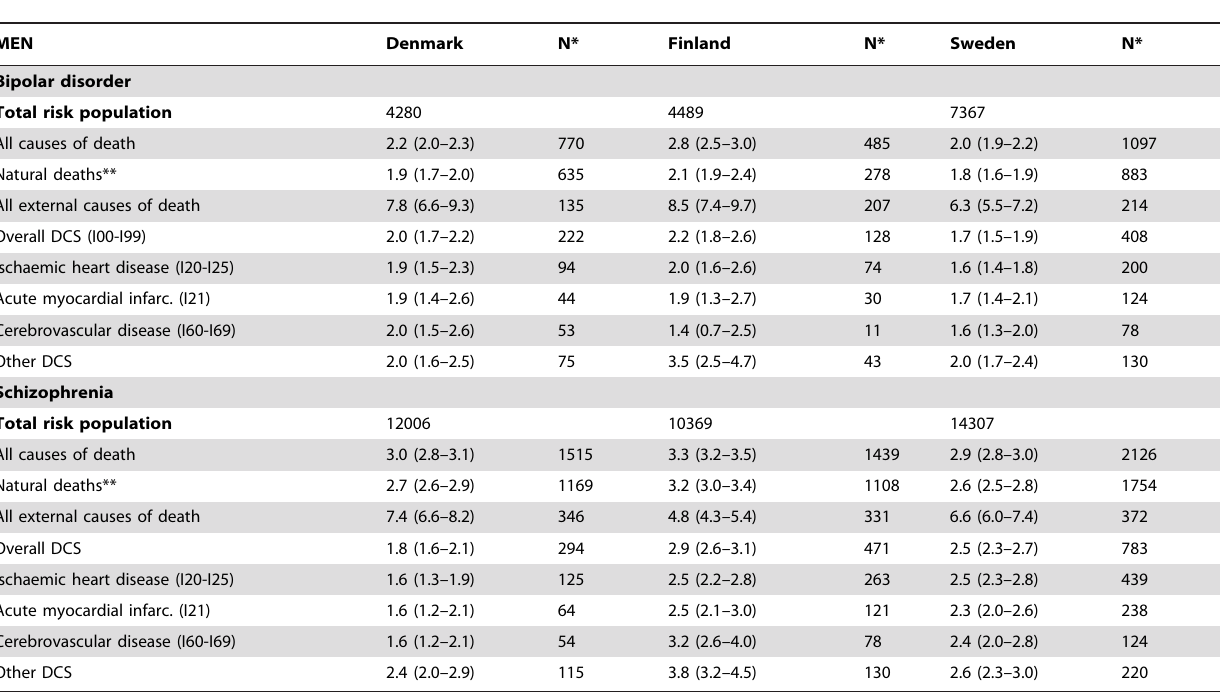
Table 1. Standardized mortality rates (SMR) for overall mortality, natural/unnatural causes and a sub-division of diseases of the circulatory system (DCS; ICD I00-I99) for men with bipolar disorder/schizophrenia compared to the general population in Denmark, Finland, and Sweden with 95% confidence